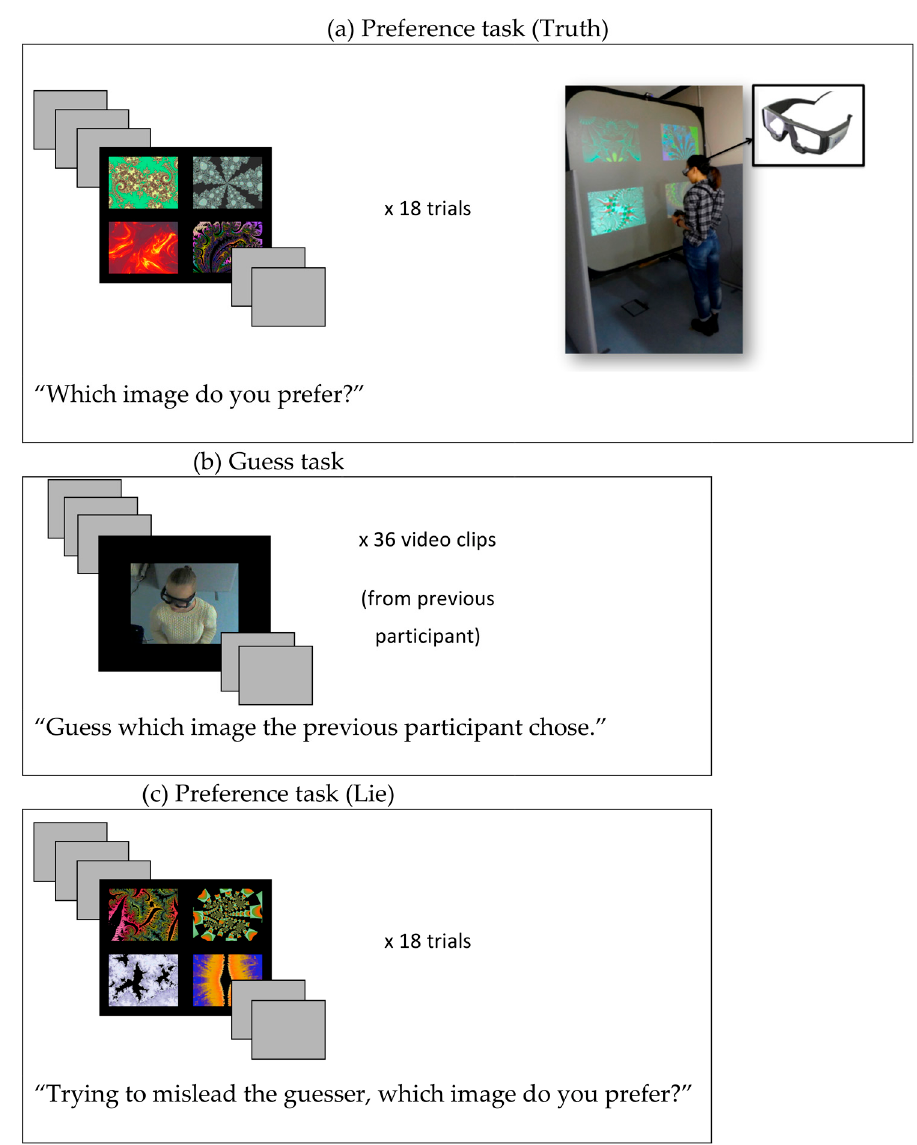
Figure 1. The procedure in Experiment 1, which consisted of 3 blocks: ( a ) A preference task where participants stood in front of a large screen and chose which of 4 images were preferred, while eye and head movements were recorded; ( b ) An inference task, where videos of the previous observer were displayed and participants had to guess their response; ( c ) A second preference block where participants made a preference judgement while being aware of the guesser and in an attempt to mislead them. A brief version of the instructions is included in each case. Re-played trials in ( b ) came from parts ( a , c ) in the previous participant.